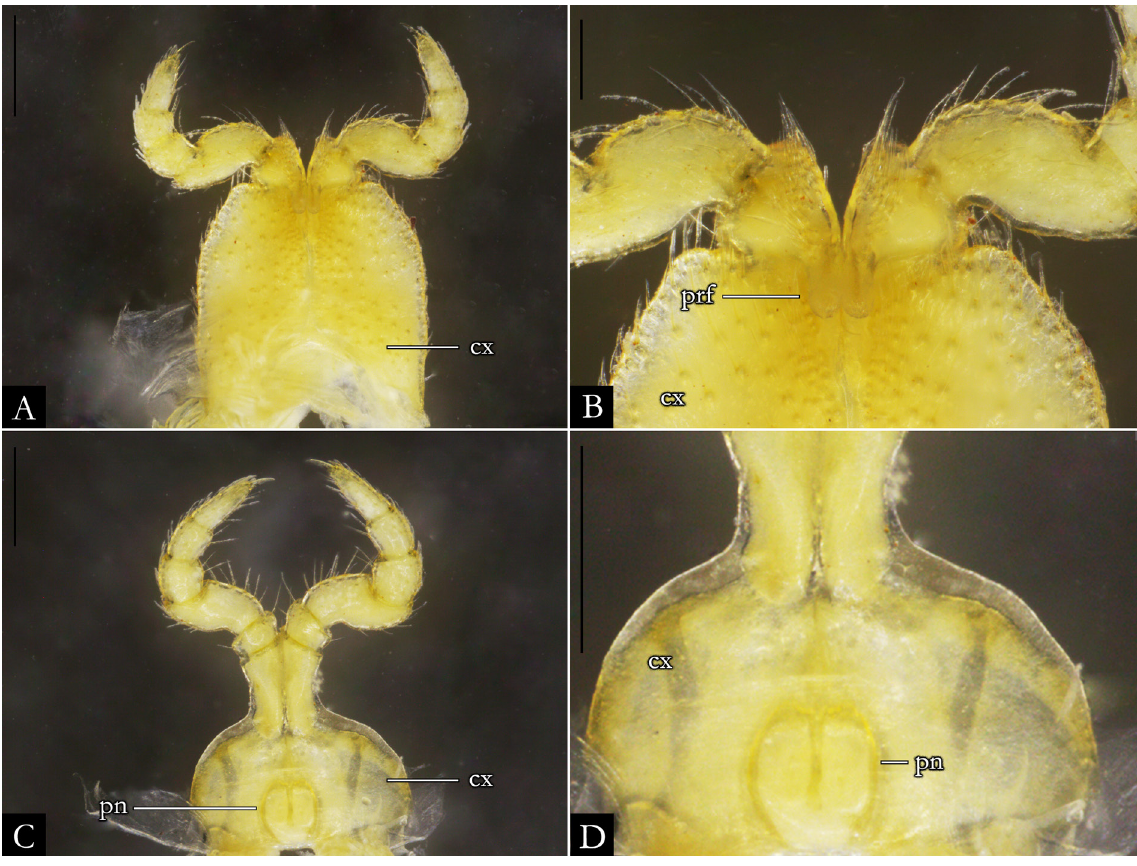
Fig. 107. Pseudonannolene patagonica Brölemann, 1902, holotype, ♂ (MZSP 0242). A . First leg-pair. B . Detail of prefemur. C . Second leg-pair. D . Detail of penis. Abbreviations: see Material and methods. Scale bars: A, C = 0.5 mm; B, D = 0.2